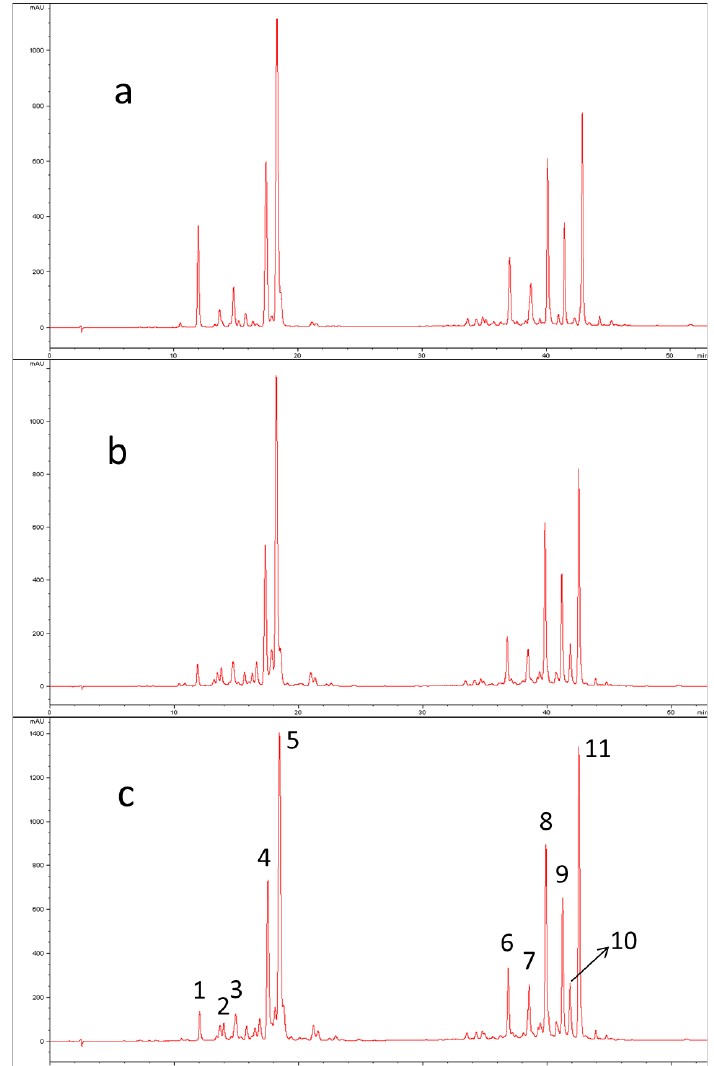
Figure 2. HPLC-UV/Vis chromatograms of “Delica” pumpkin extracts: ( a ) raw fresh sample; ( b ) steam cooked sample; ( c ) oven cooked